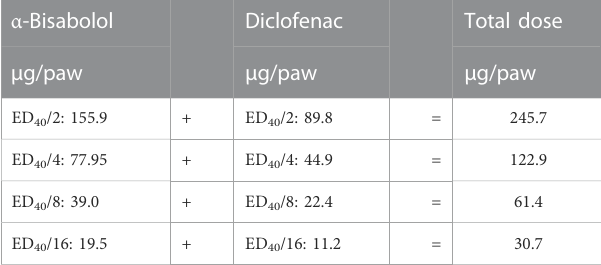
TABLE 1 Dosing amount of each drug in the combinations according to the ED 40 of α -Bisabolol (311.8 µg/paw) and diclofenac (179.6